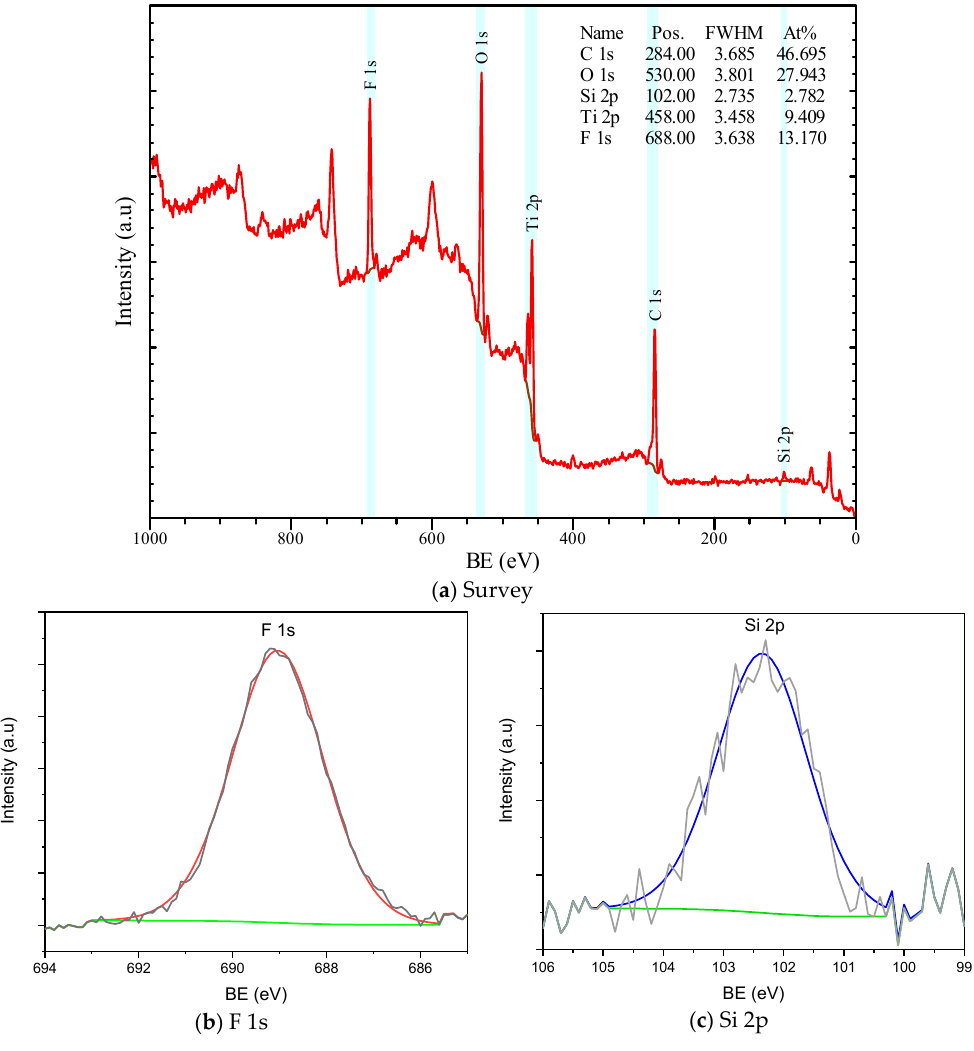
Figure 6. Conventional XPS analysis of a PFDS/TIPT condensed film. ( a ) Survey spectrum with details of surface elements and stoichiometry. ( b ) Characteristic F 1s core level and ( c ) Si 2p core level.